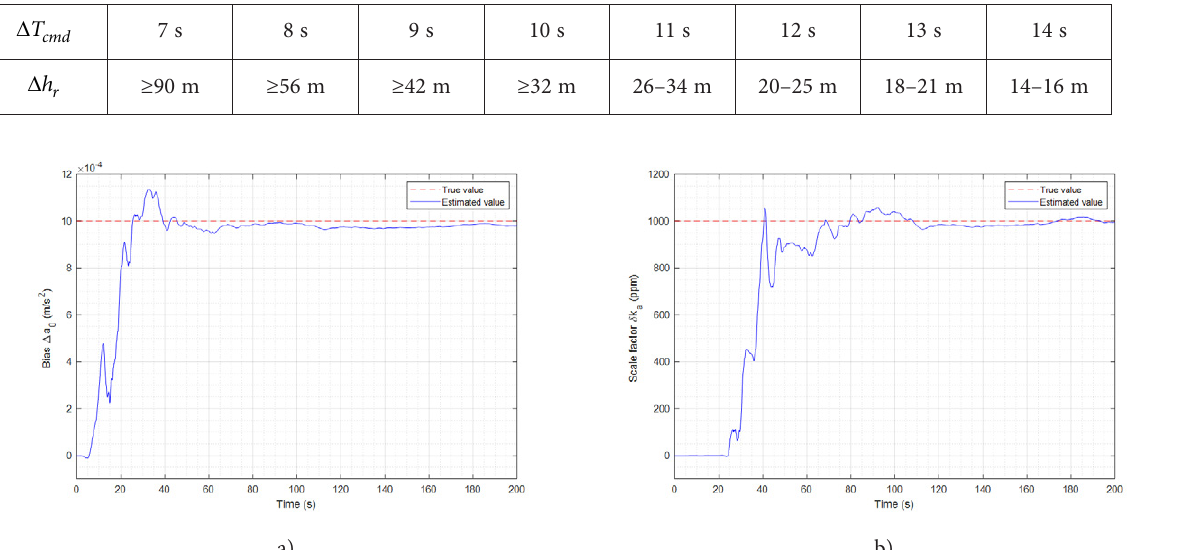
Table 1. Required value of reference altitude change